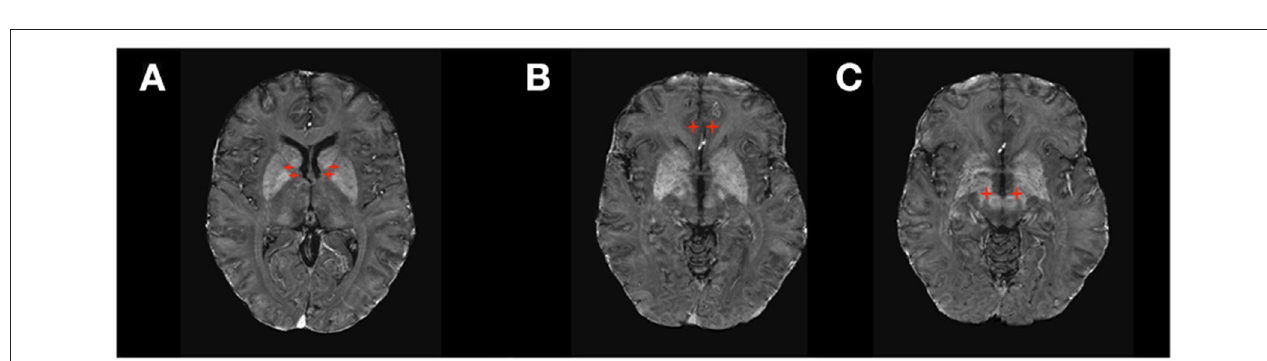
FIGURE 2 | DBS targets in Epilepsy. (A) Anterior Thalamic Nucleus (ANT); (B) Centromedian Thalamic Nucleus (CM); (C) Hippocampus.